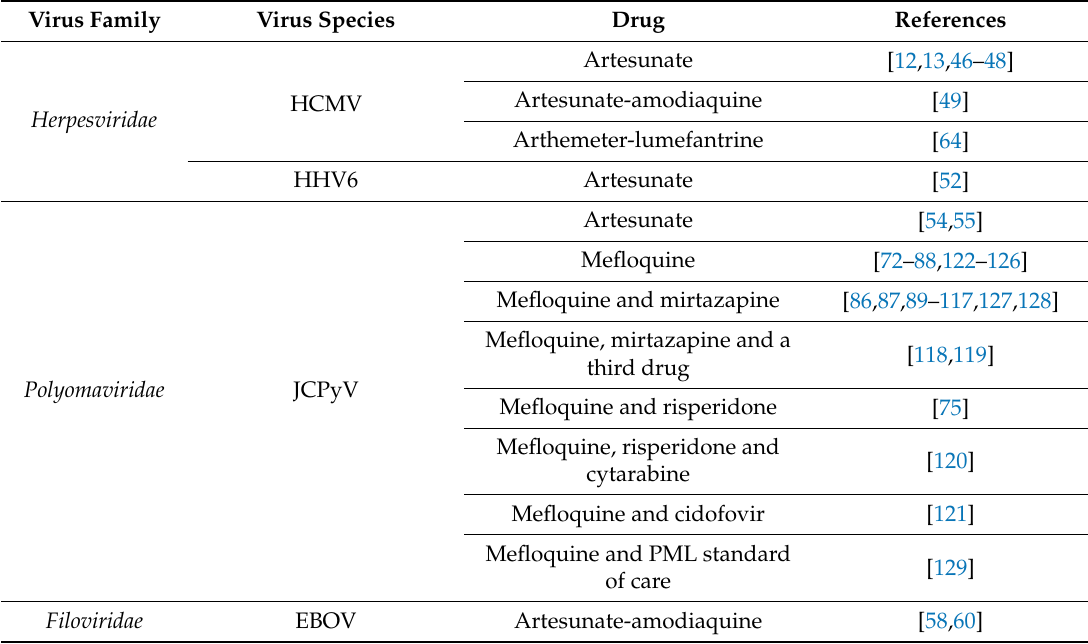
Table 4. Clinical studies for the assessment of antimalarial drug activity against viral infection. Virus Family Virus